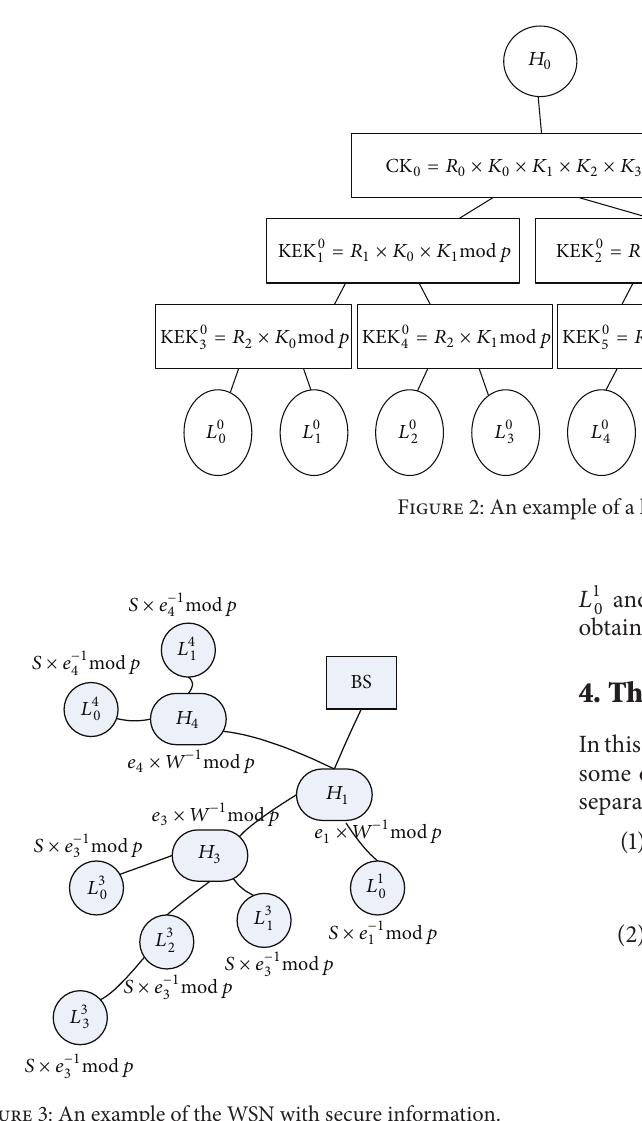
Figure 3: An example of the WSN with secure